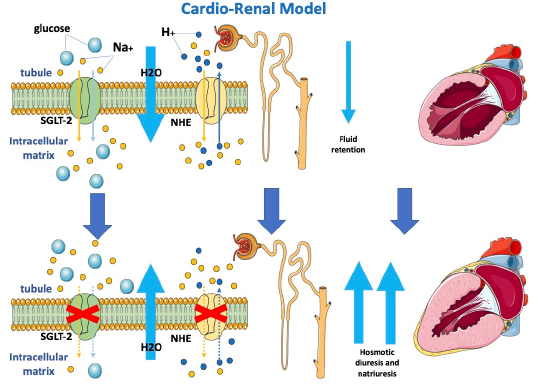
Figure 1. Effects of SGLT2-i on the cardio-renal